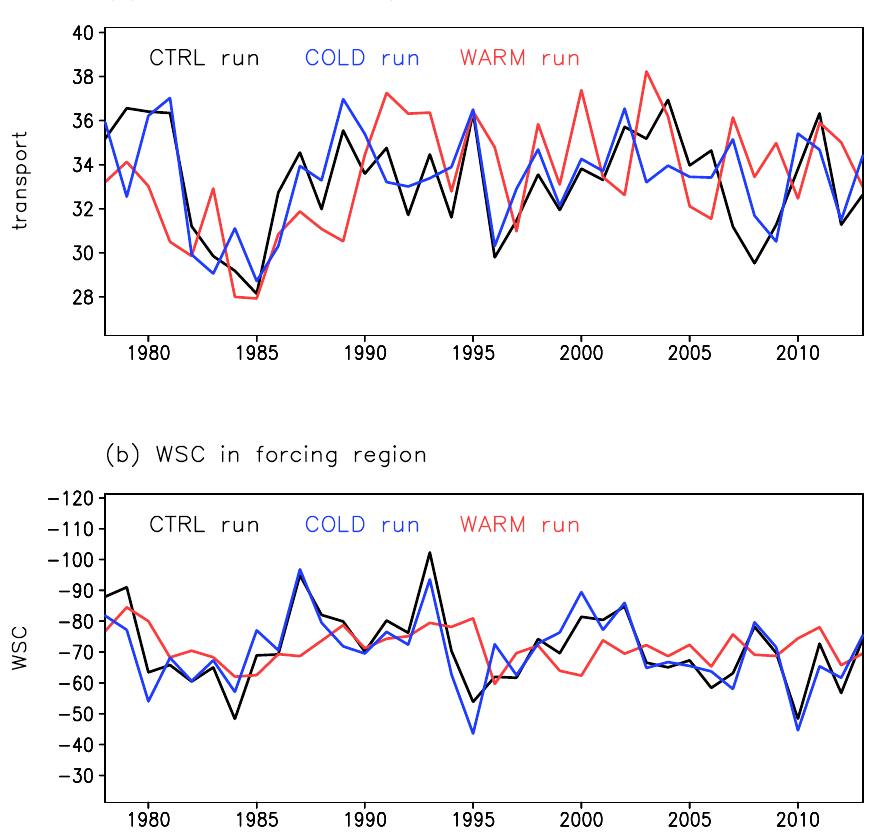
Figure 4. Temporal variations of net Kuroshio transport and WSC in the central North Pacific. ( a ) Black, blue, and red lines indicate net Kuroshio transport (Sv) across 137°E in the CTRL, COLD, and WARM runs, respectively. ( b ) Same as ( a ), but for WSC (10 –9 kg m –2 s –2 ) in the forcing region (30–37°N,